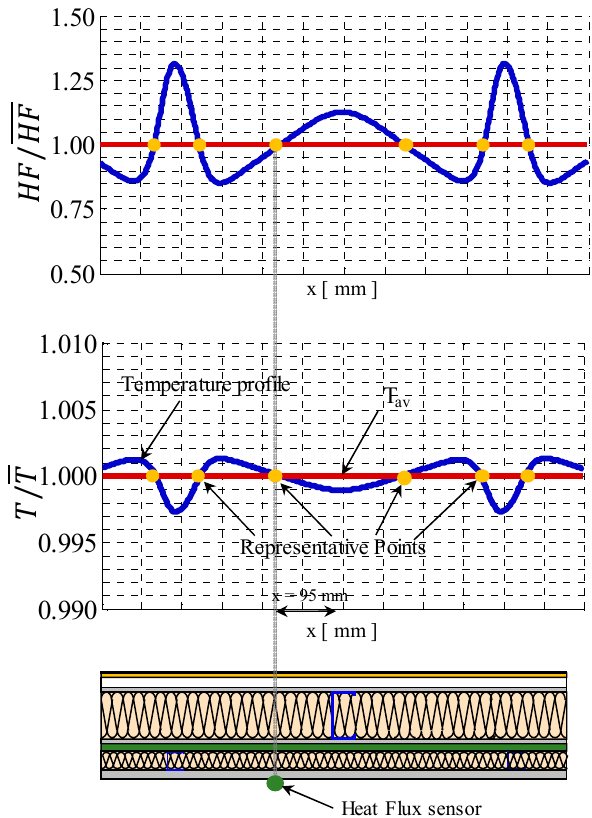
Figure 9. Identification of the representative points according to the numerical analysis.